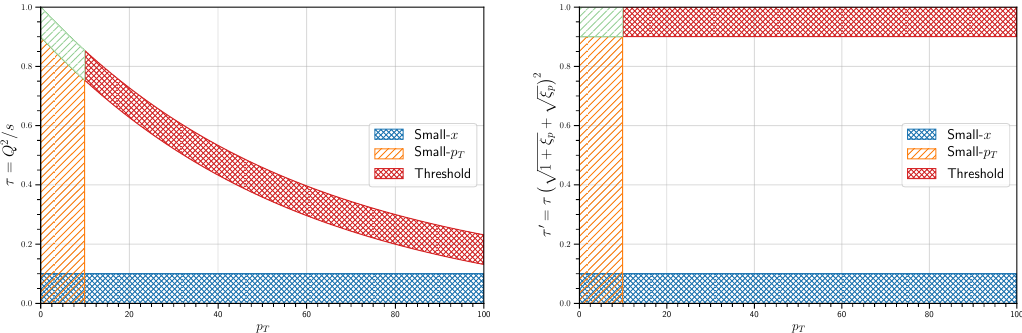
Figure 1. Available phase space for the production of a final-state system F with an invariant mass Q and a transverse momentum p T in the three kinematic limits (threshold, collinear, high-energy), parametrized in terms of the kinematic variable τ = Q 2 /s ( left ) and τ 0 ( right ). small p and large x respectively. One possible expression of dˆ σ T in ref.